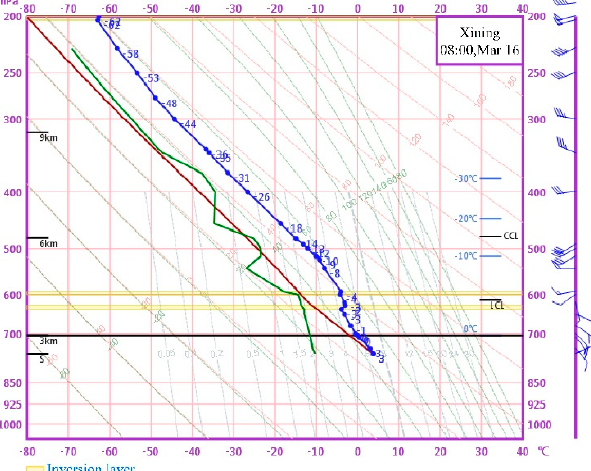
Figure 9. Structure of the T-lnp diagram (emagram) of Xining City at 08:00 on 16 March 2021.